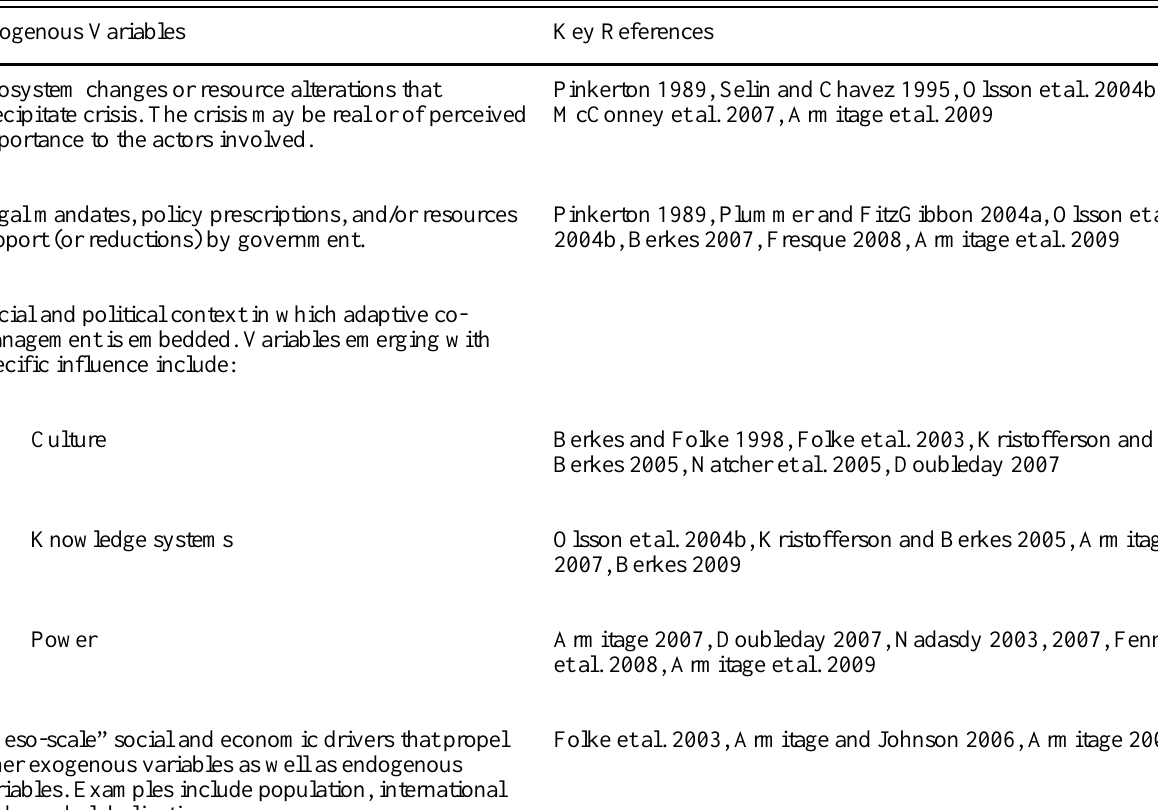
Table 1. Analytical framework of exogenous variables influencing the process of adaptive